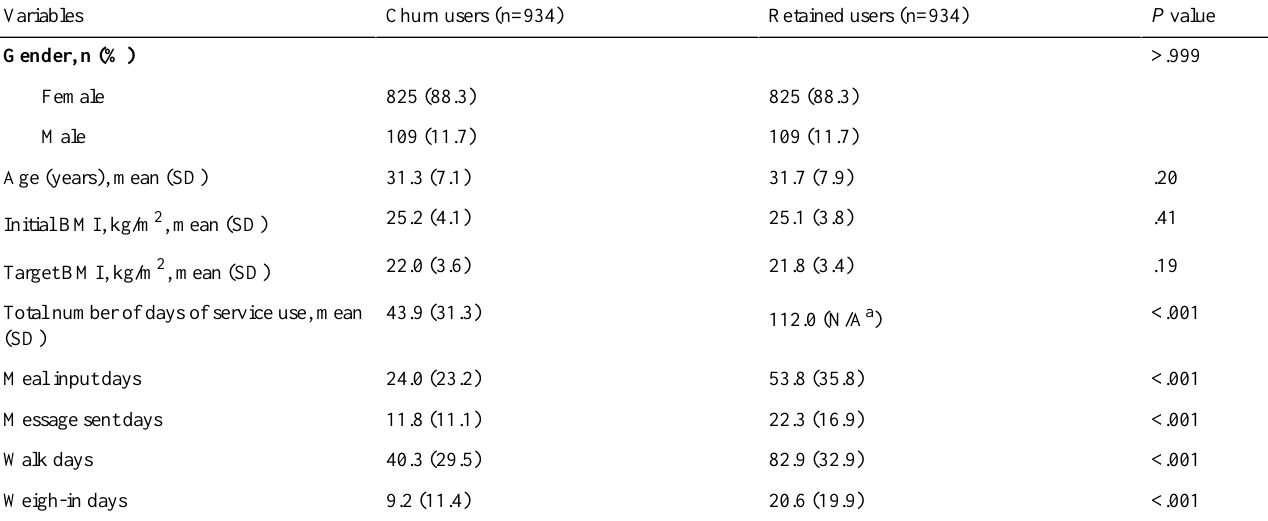
Table 1. Demographic